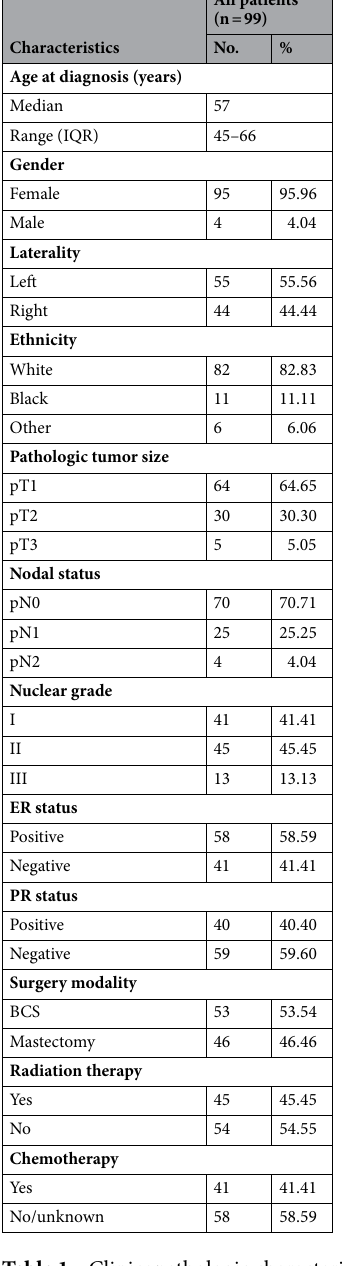
Table 1. Clinicopathologic characteristics and type of treatment of all patients included. pT1 pathological tumor size ≤ 2 cm, pT2 2 cm < pathological tumor size ≤ 5 cm, pT3 pathological tumor size > 5 cm, pN0 negative differentiation, ER estrogen receptor, PR progesterone receptor, BCS breast conserving